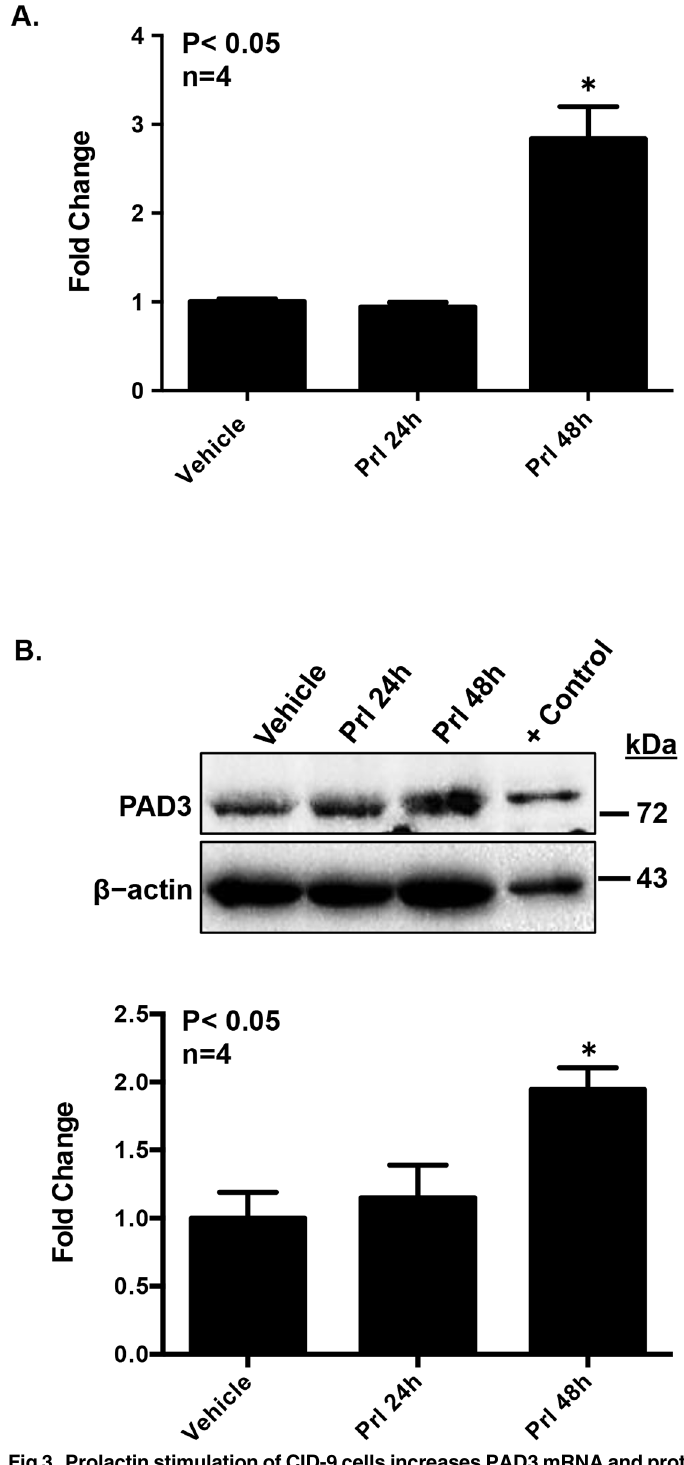
Fig 3. Prolactin stimulation of CID-9 cells increases PAD3 mRNA and protein expression. Equal numbers of CID-9 cells were grown in phenol red free media with charcoal-stripped FBS overnight. The following morning cells were treated with vehicle or 5 μ g/mL of prolactin for 24 or 48 hours. (A) Prolactin treatment significantly increases PAD3 mRNA. Total RNA was extracted from CID-9 cells, reverse transcribed, and resulting cDNA examined by qPCR with intron spanning primers specific for PAD3